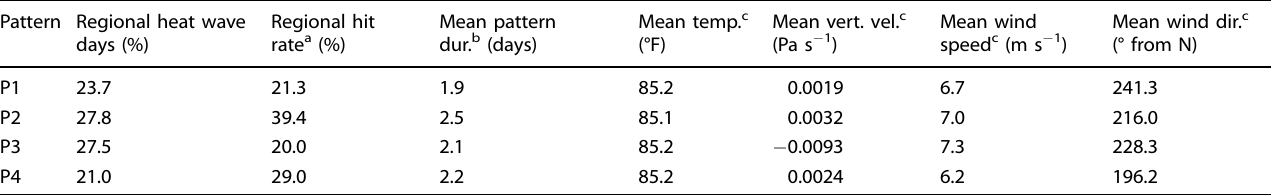
Table 3. Characteristics of the four patterns associated with Northeast heat wave events. Pattern Regional heat wave days